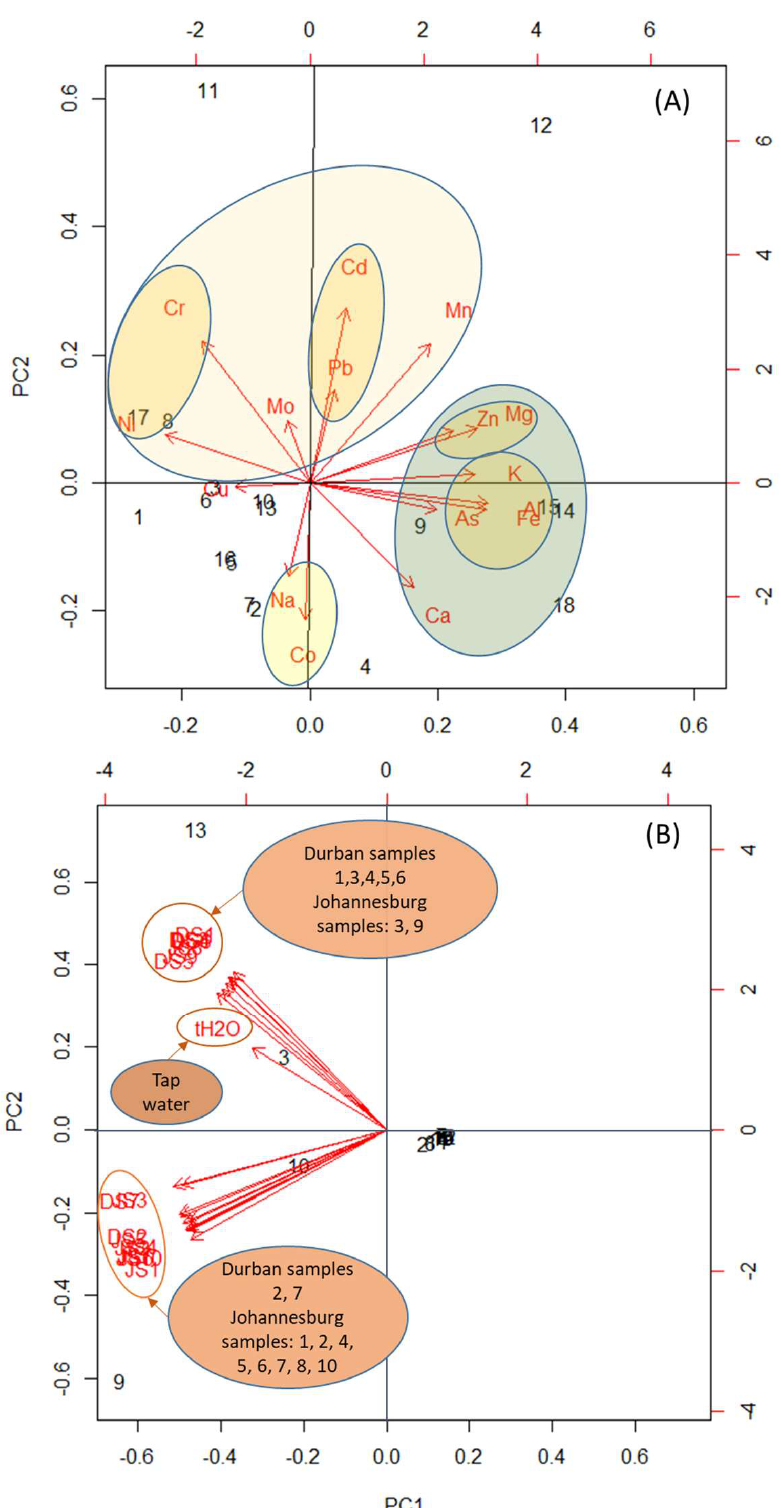
Figure 2. Principal component analysis representing correlational behaviors between ( A ) metals and ( B ) samples. PC1 and PC2 refer to principal components 1 and 2, respectively.